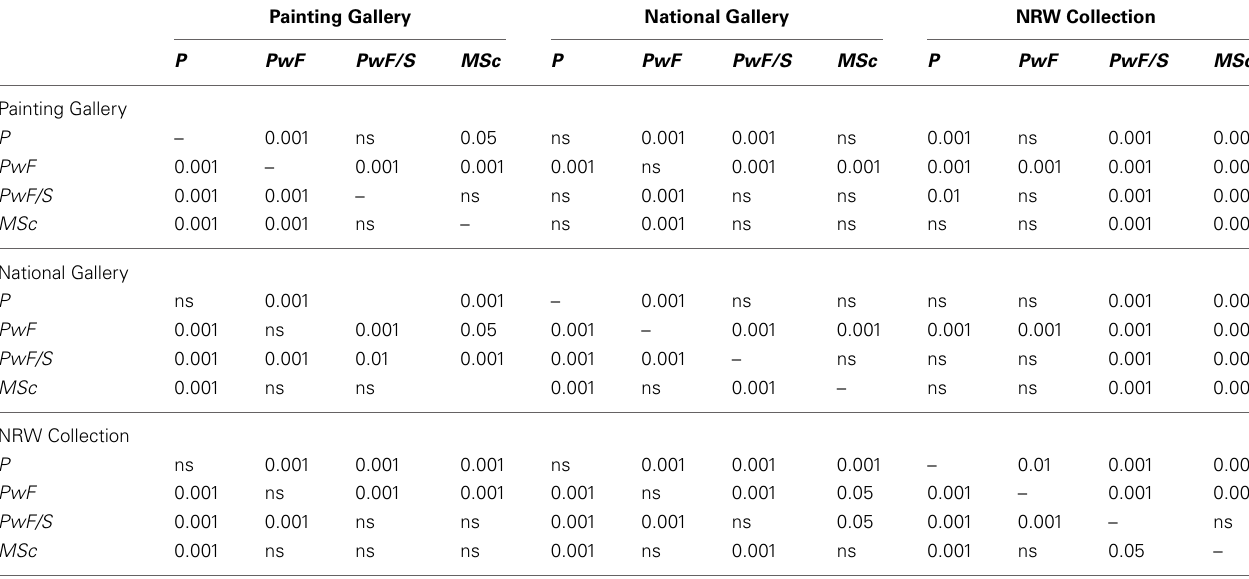
Table 3 | Significance levels ( p < ... ) for the differences in complexity (upper right half of the table) and self-similarity (lower left half) between the different image categories in the three museums (Kruskal-Wallis test with Dunn’s post-test). Painting